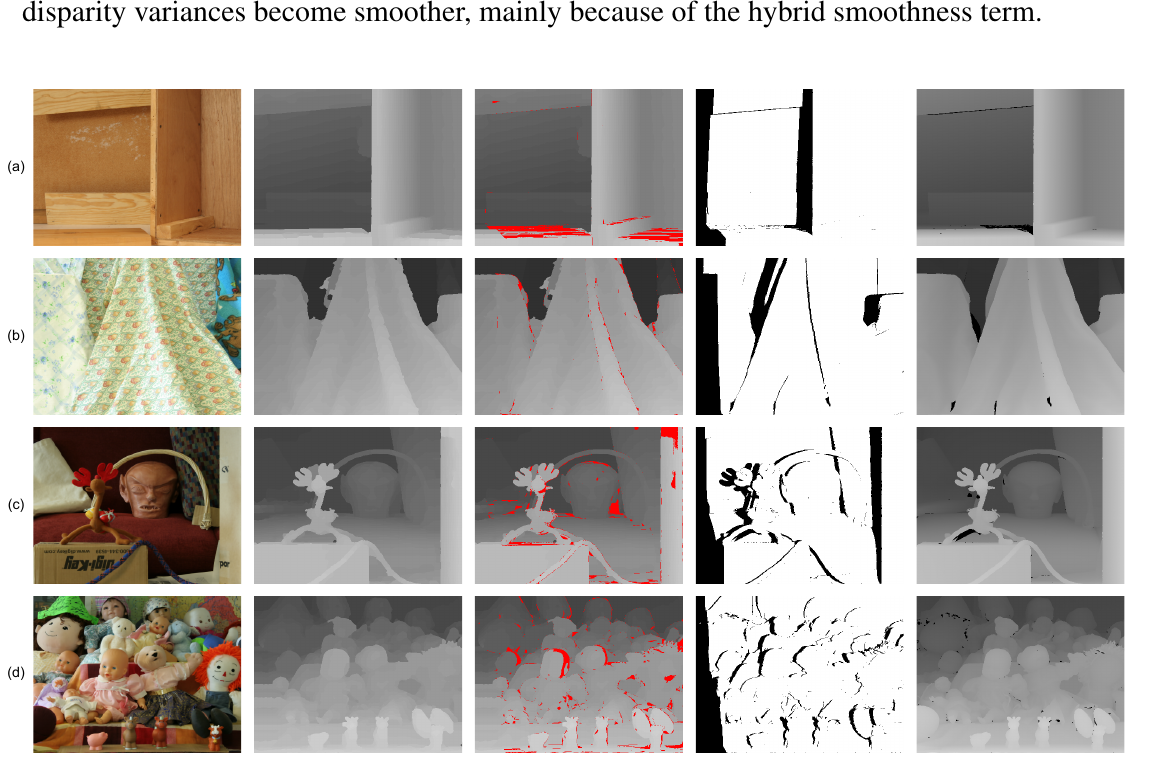
Figure 12. Evaluation results on the Middlebury extension datasets. ( a ) Wood1; ( b ) Cloth4; ( c ) Reindeer; ( d ) Dolls. Each row contains (left to right): the left image, our results, the error map (from top to bottom, the percentages of error pixels with absolute disparity error larger than one in non-occlusion regions are: 4.35%, 1.03%, 4.31%, 4.78%; error pixels are marked red), the occlusion map (occluded pixels are marked black) and the ground truth